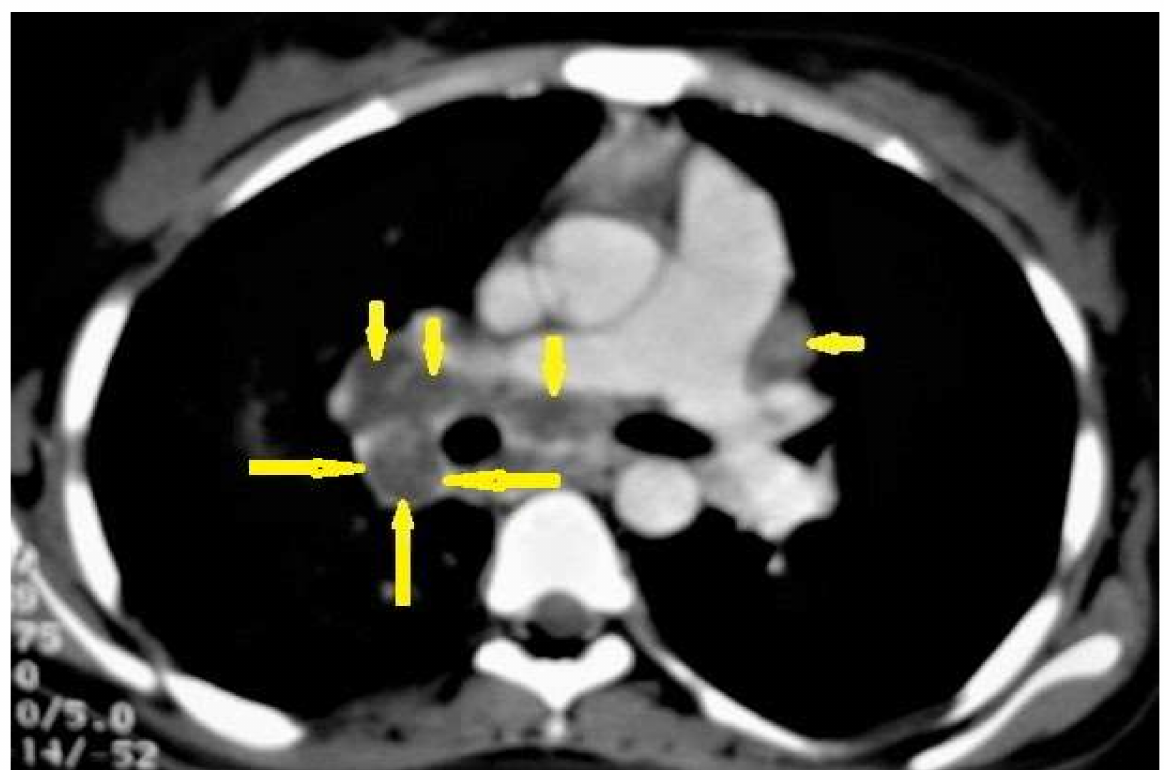
Figure 1. Primary TB in an 18-year-old man. Axial mediastinal-window CT image shows multiple enlarged mediastinal lymph nodes (short arrows), and right hilar lymph nodes are characterized by central low density and peripheral enhancement after contrast administration forming the rim sign (long